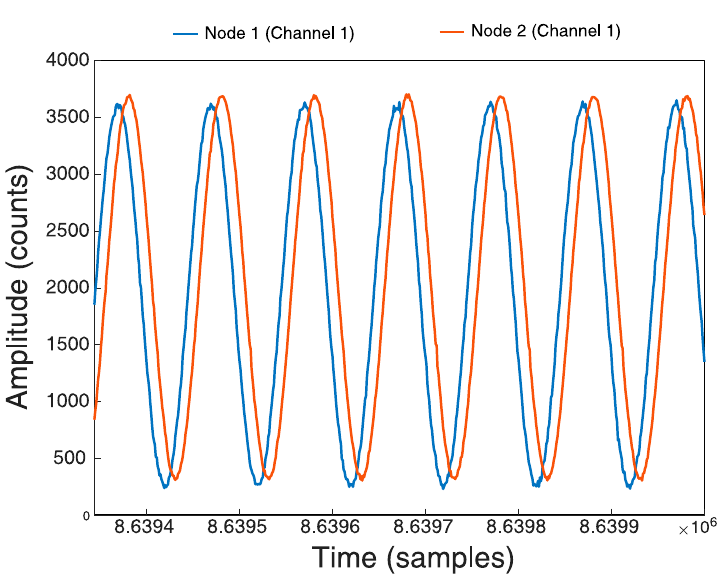
Figure 17. Final signal in 24 h register with Stop-and-Go.